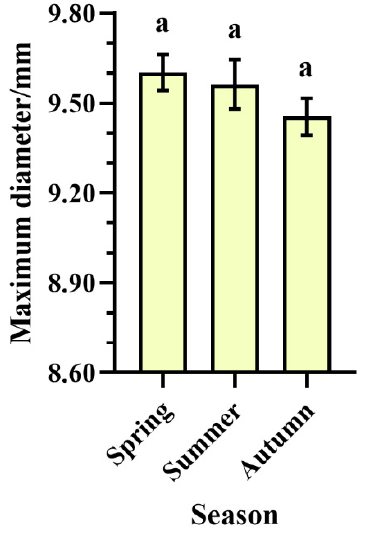
Fig 4 . Comparison of maximum diameter of swarm cells among seasons.